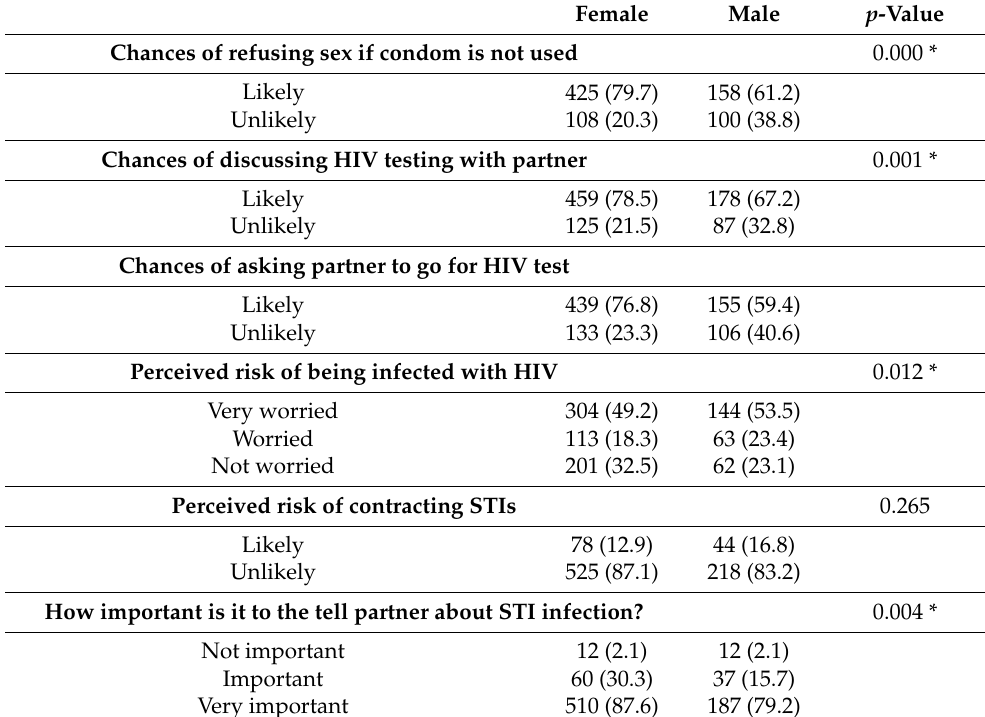
Table 3. Reported preventive sexual behaviours and perceptions of risk of acquiring HIV.